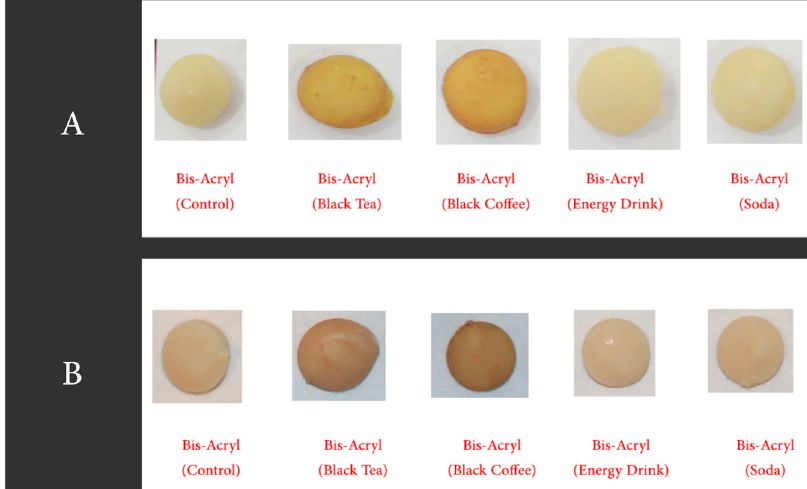
Fig. 5 Bis-acryl Speciments ready for measurements. A Bis-acryl (after 2 weeks). B Bis-acryl (after 4